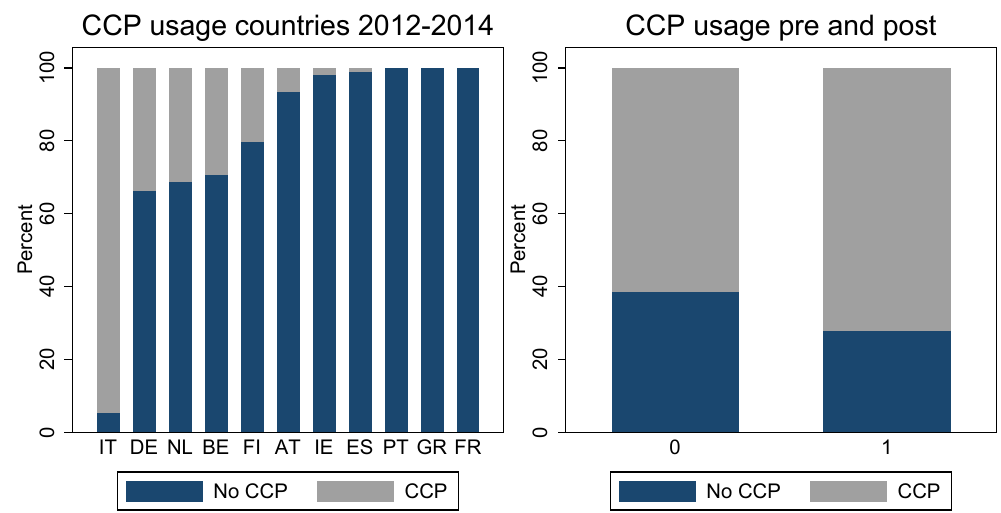
Figure 2. CCP usage across countries and over time. This figure displays the percentage share of trading activity that is executed in cooperation with a CCP (gray bars) and the share of trading activity that is not routed via a CCP (dark blue bars). The trading activity measure used to create the graph is trading volume in millions of euros. On the left, we display the aggregate shares over the entire sample period from 2012 to 2014 for different countries. On the right, we show the shares pre– and post–Basel